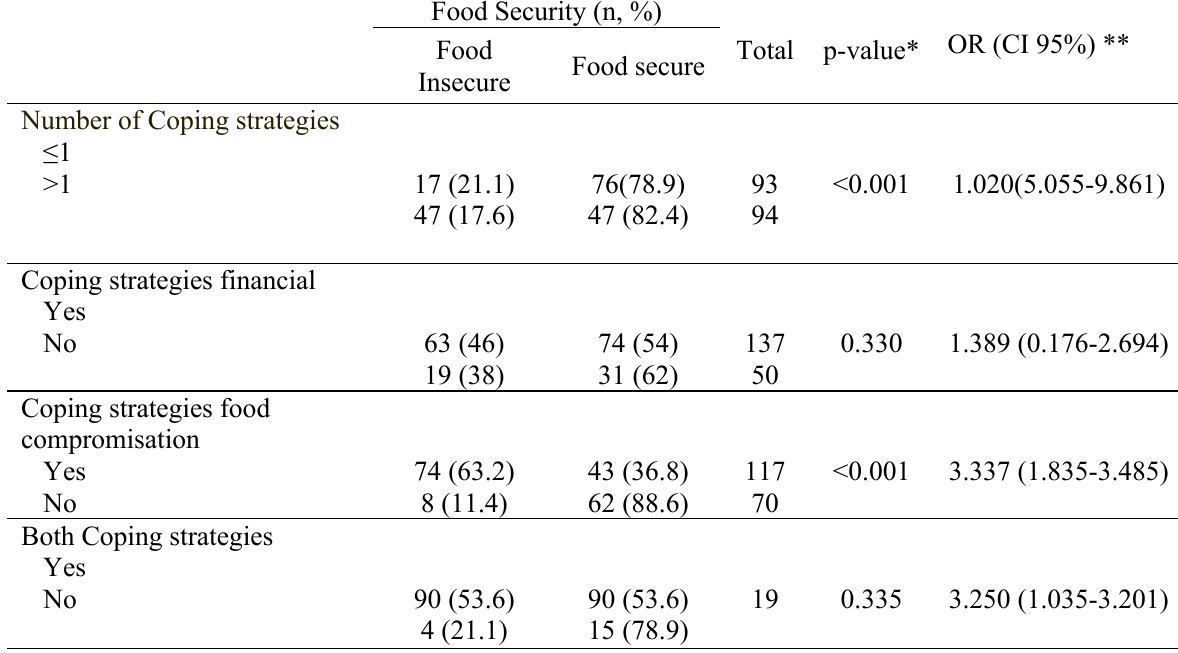
Table 3b. The association between coping strategy and household food security (n=187)